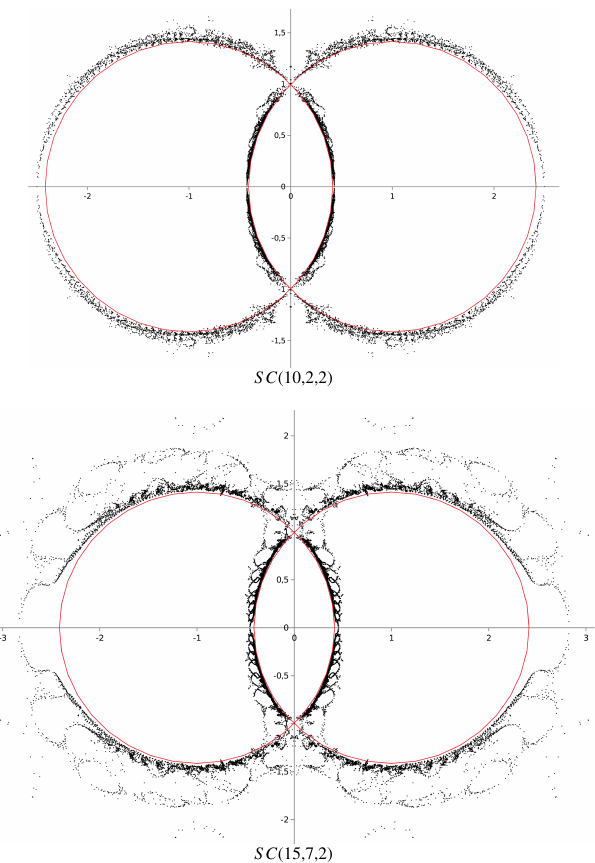
Figure 6. Spectra of the Ising model on SC ( n ; p ; k ) for p = n (cid:0)